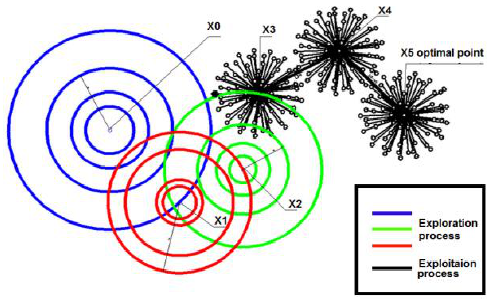
Figure 6. Mine blast algorithm (MBA) exploration and exploitation processes.